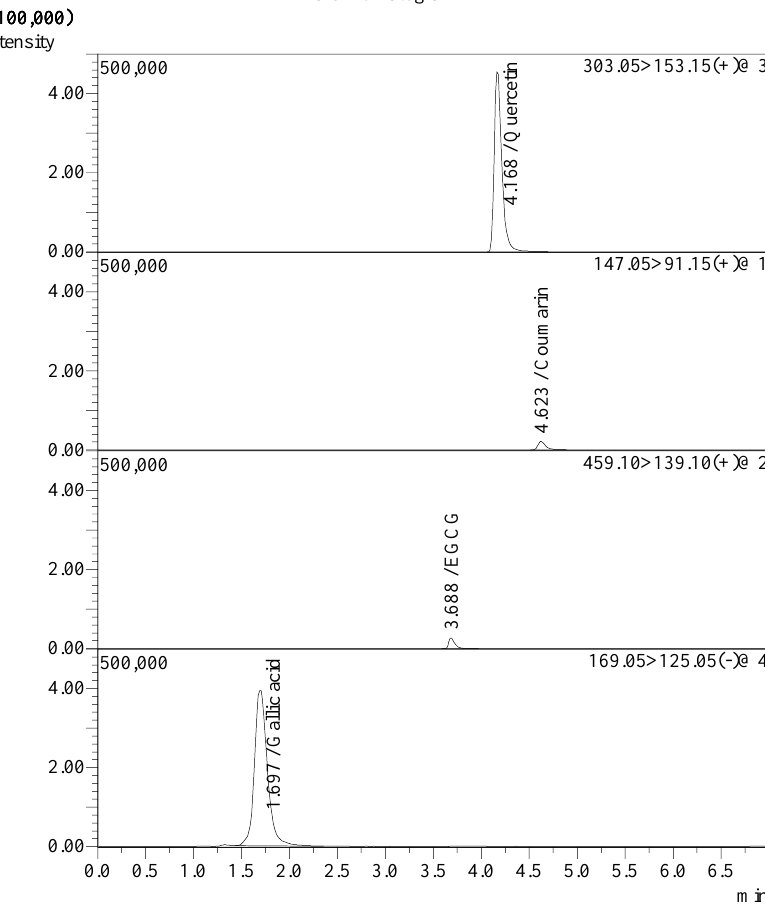
Figure 5. Chromatograms of standard compounds determined by LC–MS/MS.